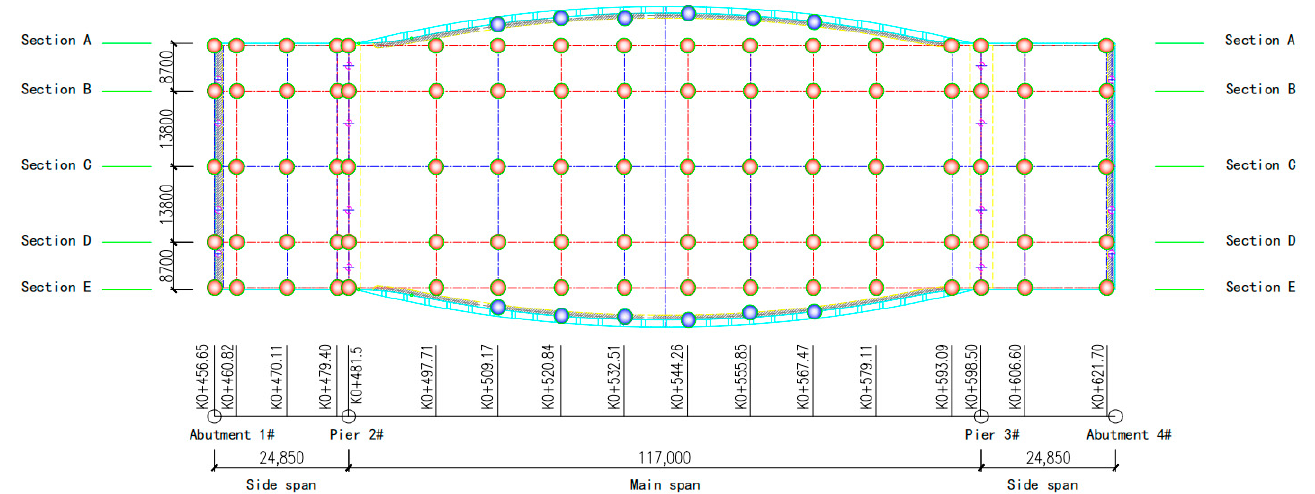
Figure 10. Deformation monitoring points of the bridge deck (unit: mm).